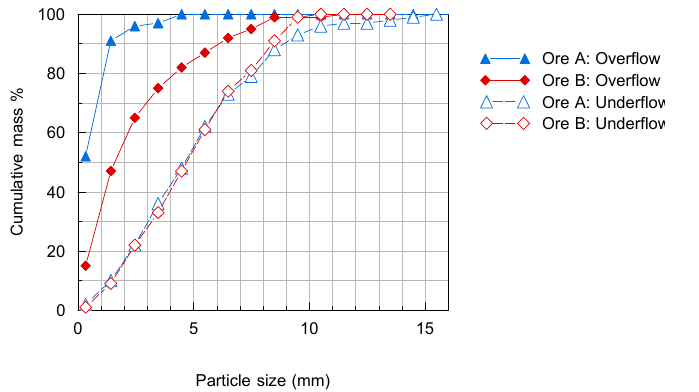
Figure 9. Cumulative particle size distribution in samples of the ore A (overflow 3.1 sinks and underflow 3.2 floats) and ore B (overflow and underflow 3.1 floats) DMC products, at densities higher than the cut-point.